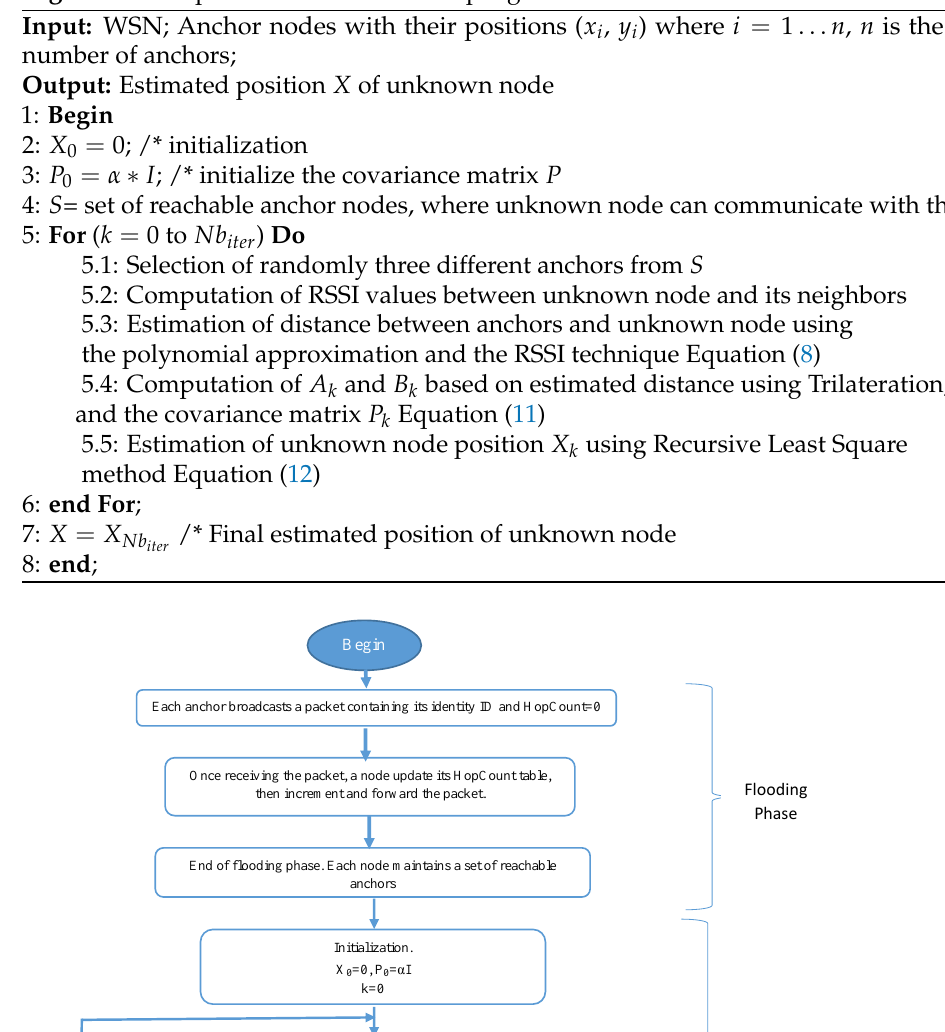
Algorithm 1 Improved recursive DV-Hop algorithm.